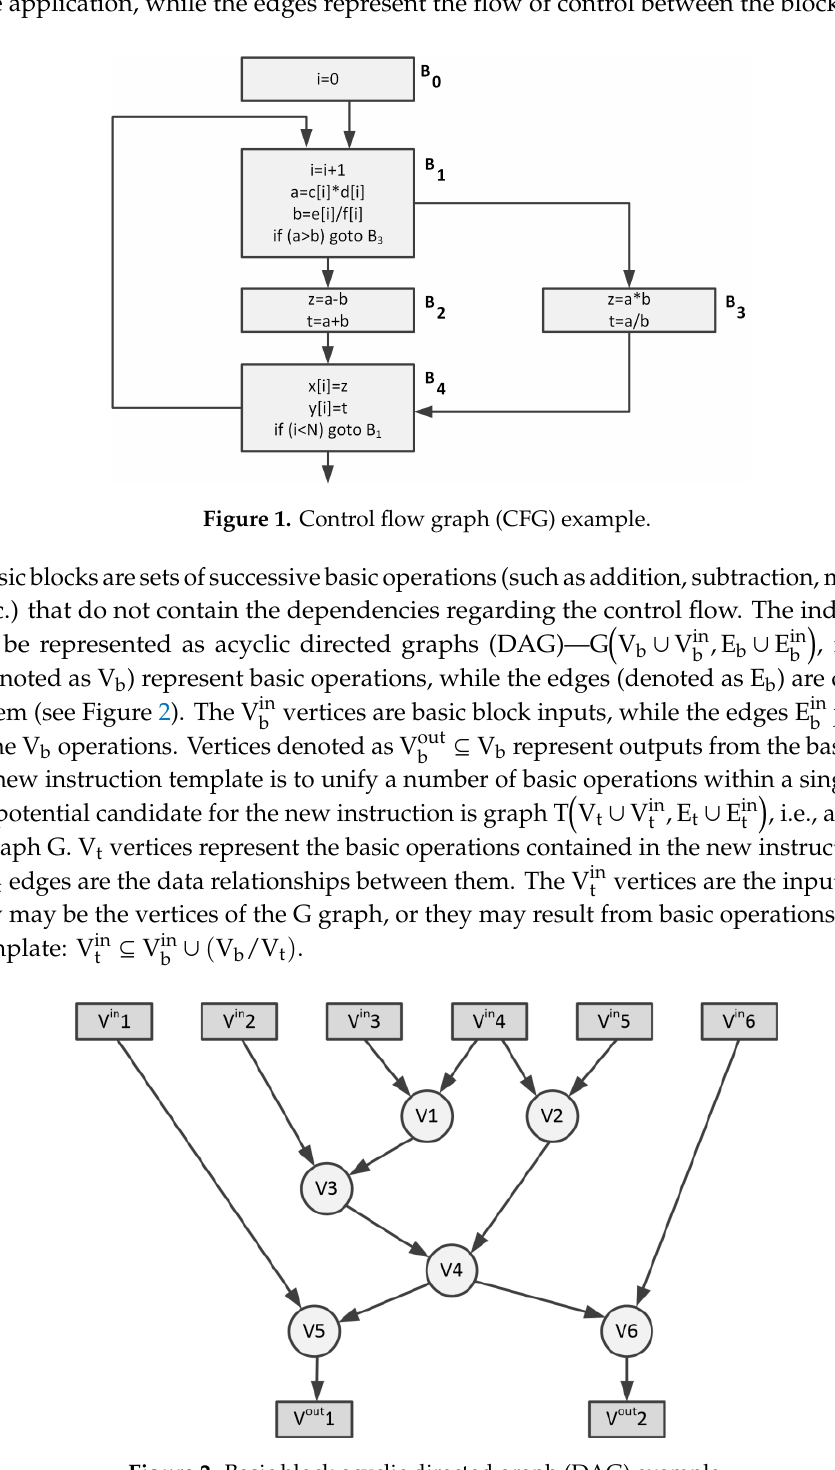
Figure 2. Basic block acyclic directed graph (DAG) example.